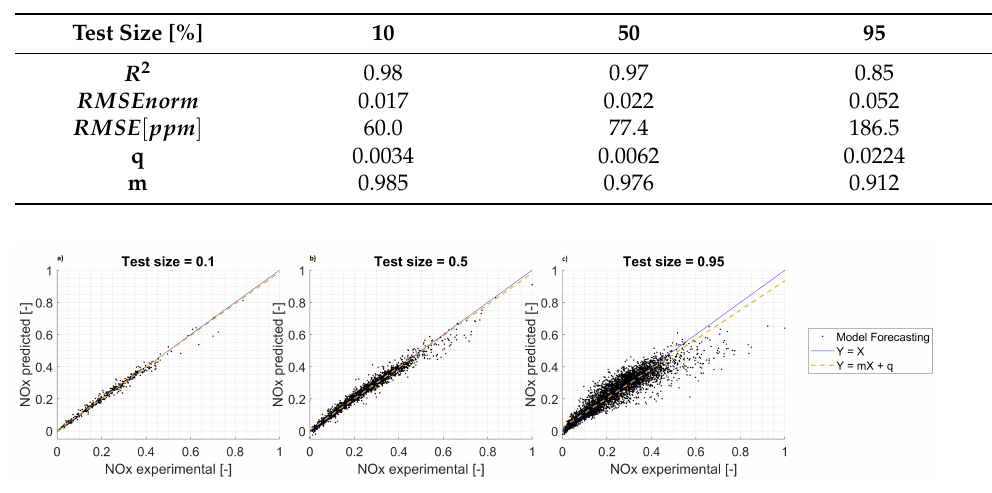
Figure 4. Regression prediction results on test dataset for bench test conditions. Sensitivity analysis on the three different sizes of test dataset: ( a ) 10%, ( b ) 50% and ( c )